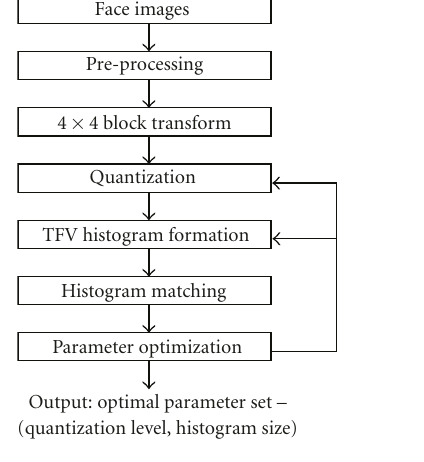
Figure 6: The parameter training process. Table 1: Results of using complete image.